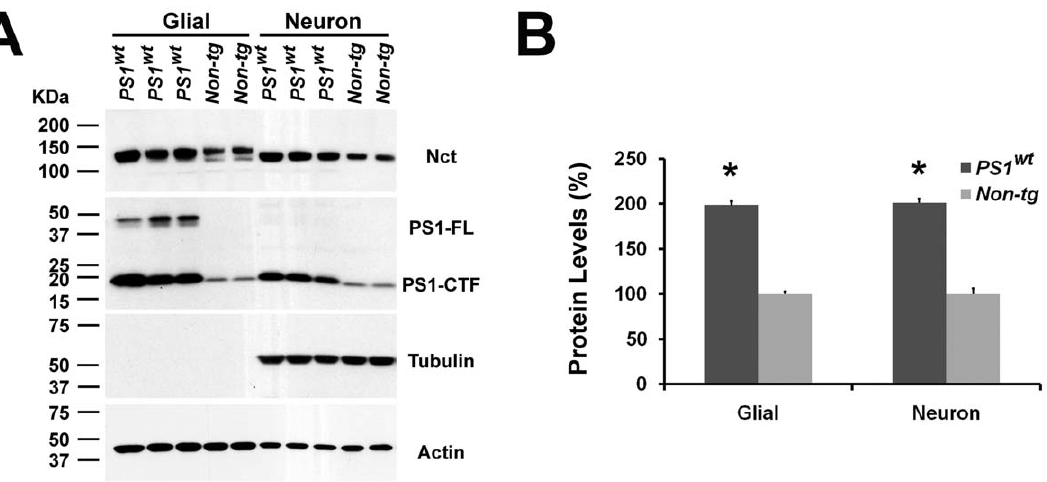
Figure 2. Increase of c -secretase in primary neurons and non-neuronal cells derived from PS1 mice. (A) Protein extracts (20 m g each) from primary neuronal and non-neuronal cultures derived from brains of PS1 and non-transgenic control mice were immunoblotted with anti-sera specific to Nct, PS1-CTF, b -Tubulin III or Actin. (B) Quantification of Nct signals in protein blot of primary neuronal and non-neuronal cell extracts by Image J program. The signal density was normalized using Actin signals derived from the same